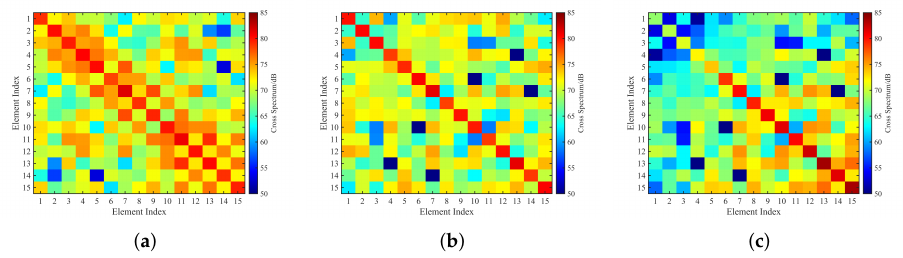
Figure 5. ( a ) The CSM of the received noise with 50 snapshots and its ( b ) whitening matrix, and ( c ) diagonalizing